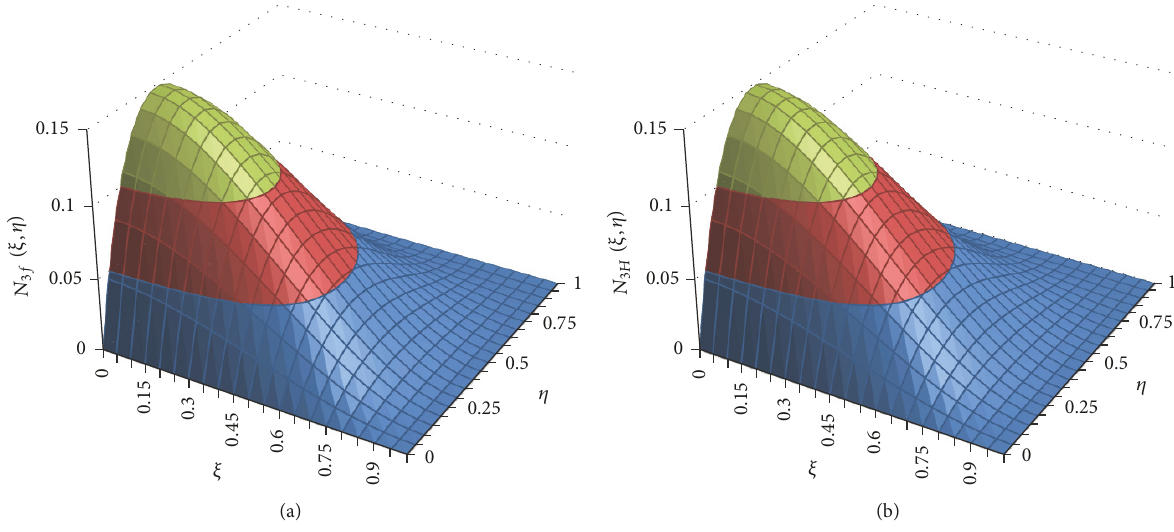
Figure 4: DFE (a) and FEM (b) shape function for 𝜃 𝑦1 at node 1.